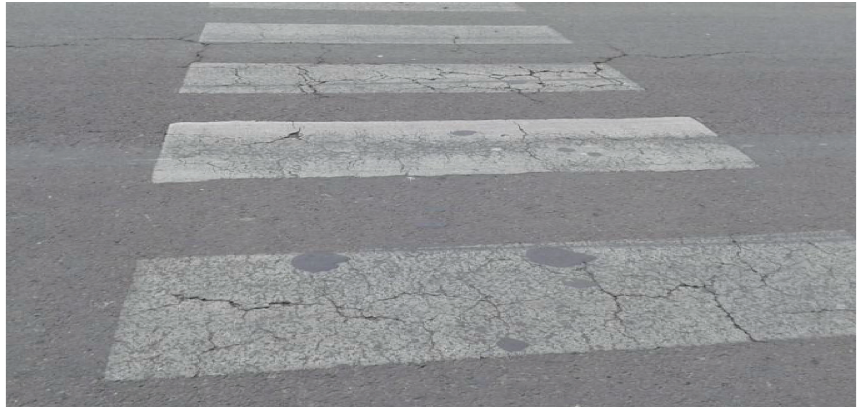
Figure 4: Cracks on the road section UR09.